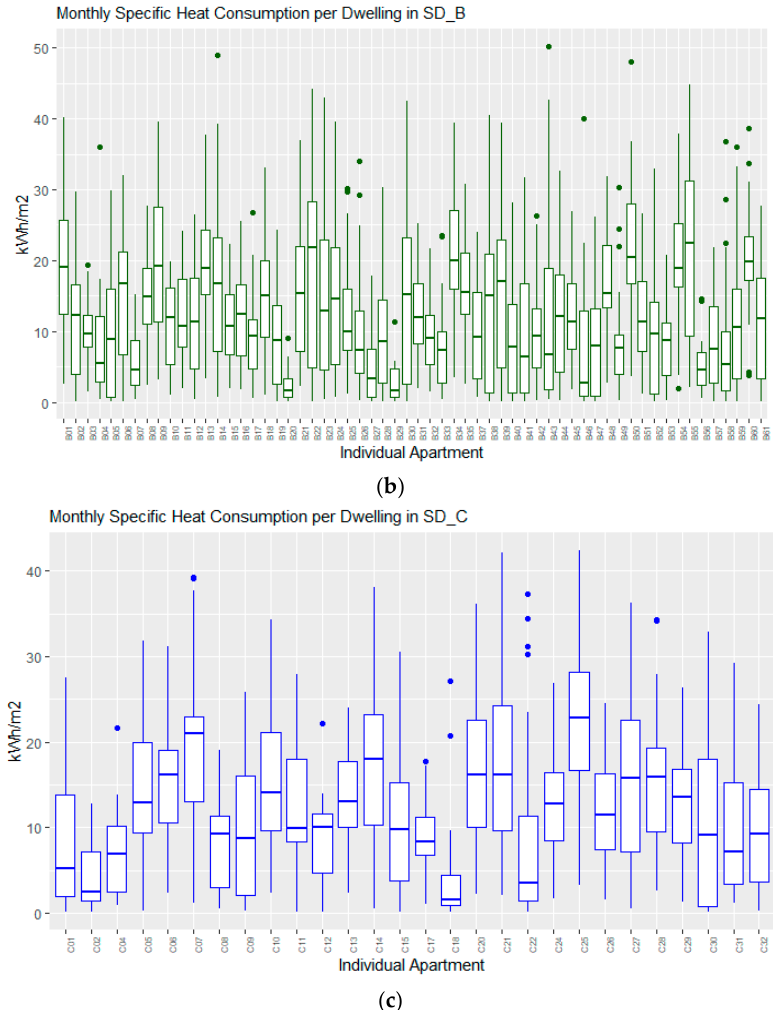
Figure 7. Visualisation of box plot diagrams for each analysed individual apartment: ( a ) Apartments in Subdivision A. ( b ) Apartments in Subdivision B. ( c ) Apartments in Subdivision C.